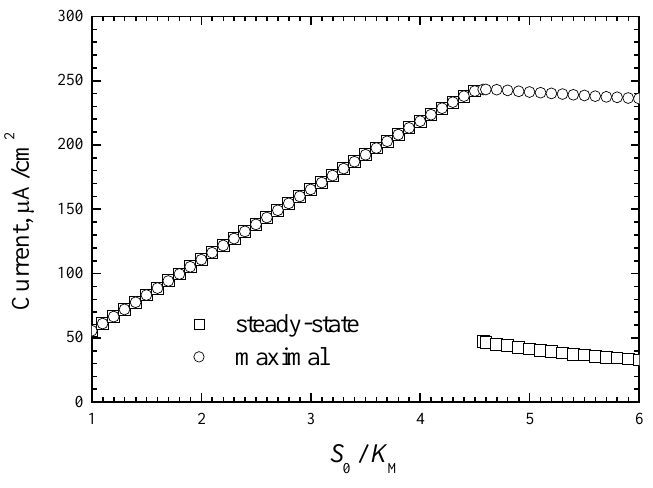
Figure 4 . Dependence of the maximal and steady-state response on the normalised substrate concentration. Calculation parameters as in Fig.